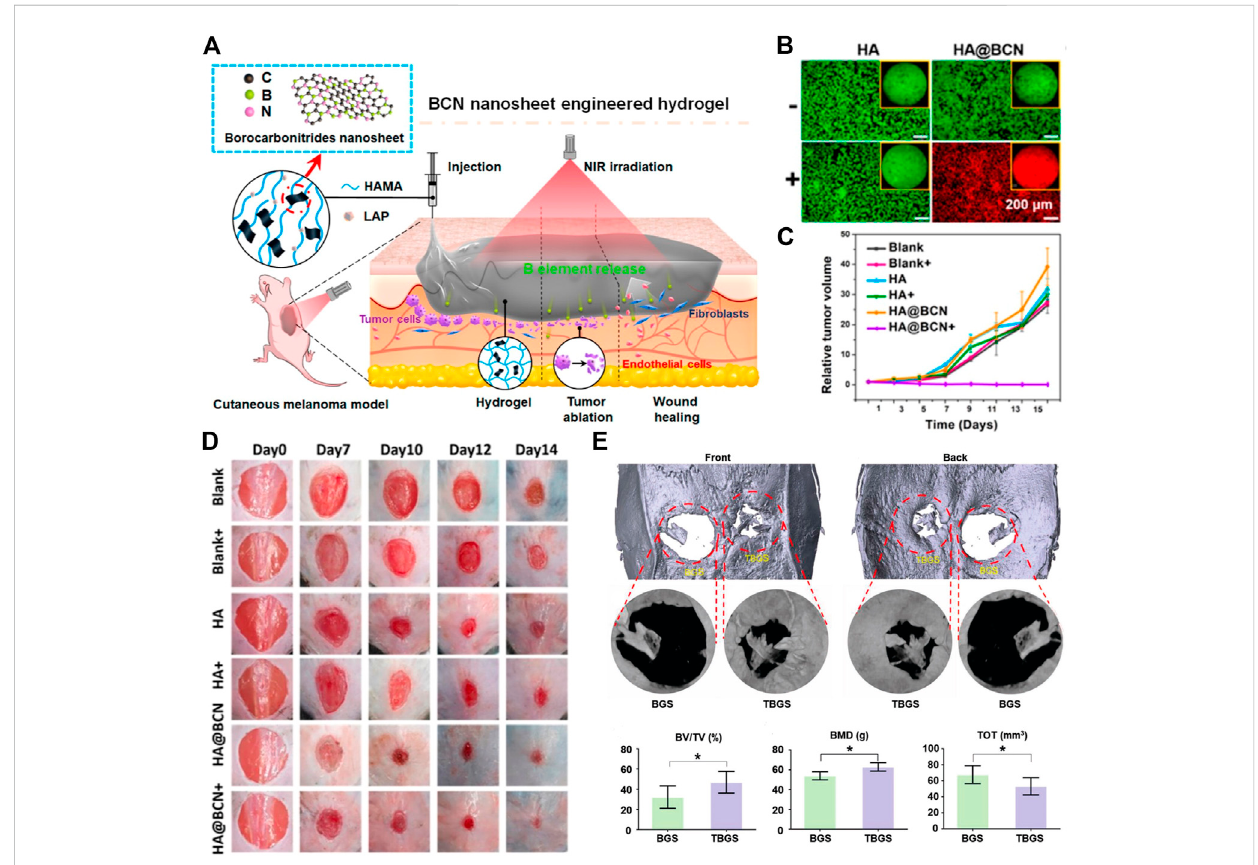
FIGURE 1 (A) Schematic illustrationofthetherapeutic strategy for melanoma based onHA@BCN. (B) Live/deadstainingofB16F10 cells indifferentgroups. (C) Growthoftumorvolumeindifferenttreatmentgroups. (D) Digitalphotographs ofskinregenerationduringtherepairperiodindifferentgroups.(Adapted withpermissionfromZhaoetal.,2022.Copyright2022AmericanChemicalSociety). (E) Micro-CTimagesandvalueofBV/TV,BMS,andTOTat24 weeks after implantation in different groups. (Adapted with permission from Pan et al., 2020. Copyright 2019